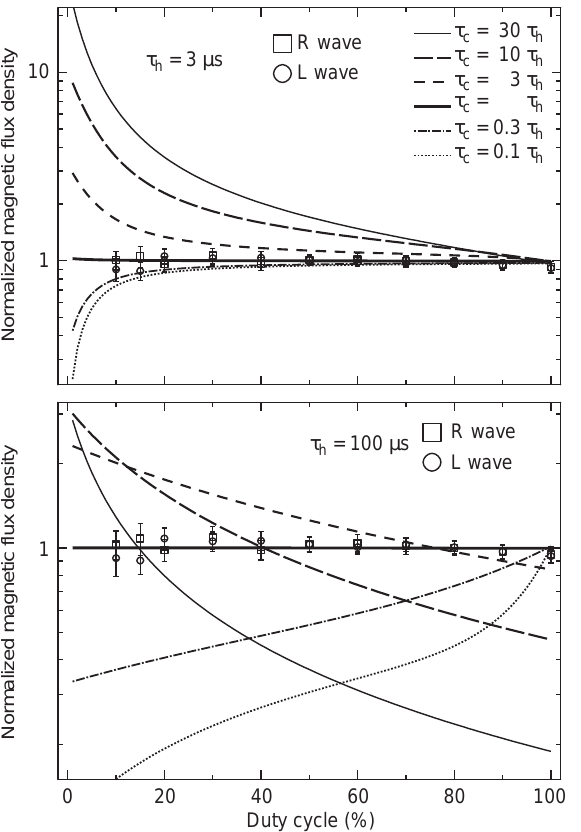
Fig. 7. Theoretical estimates of normalised magnetic flux density at 9595 Hz produced by modulated ionospheric currents, plotted for a range of six cooling time constants. Upper panel data computed for a heating time constant of 3 l s. Lower panel data computed for a heating time constant of 100 l s. The square and round markers , with their associated error bars , represent the experimentally measured ‘R’ and ‘L’ wave normalised magnetic flux